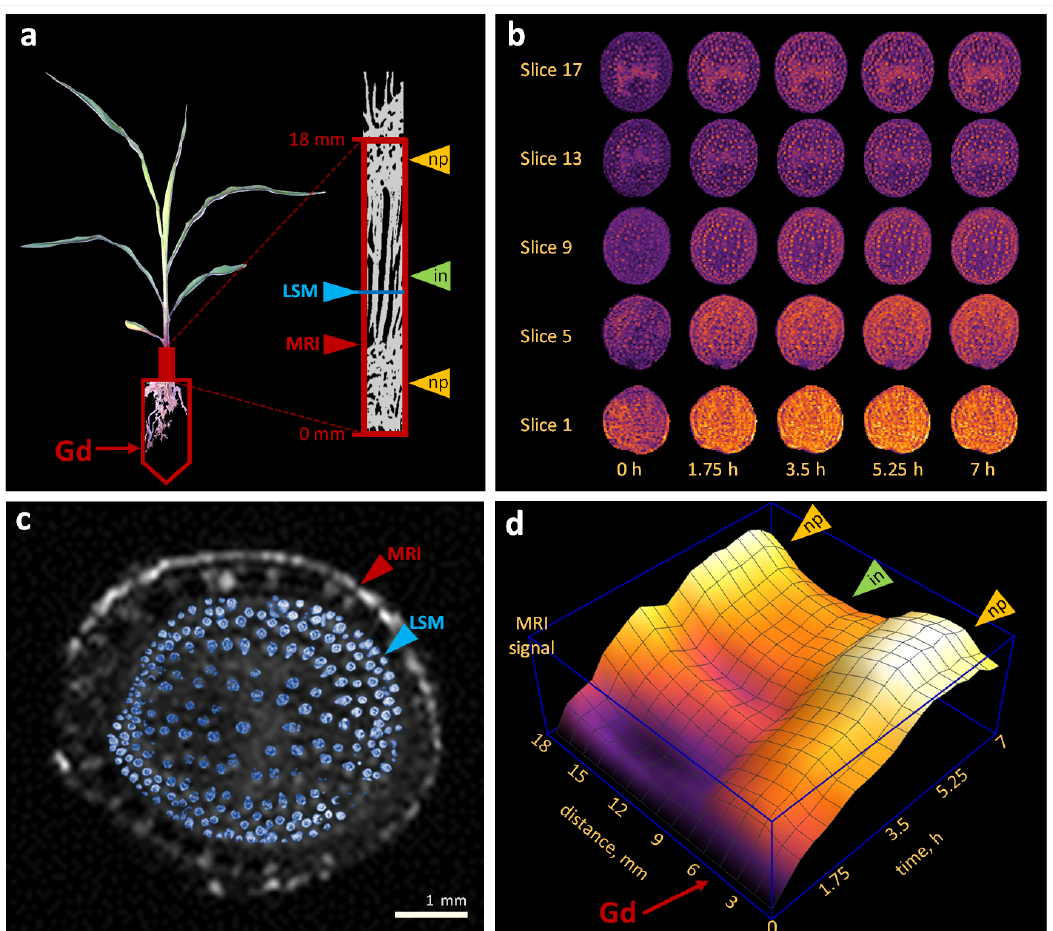
Figure 2. Contrast-enhanced MRI study of gadolinium chelate distributing inside nodal plexuses (nps) and internodes (ins) of the maize stem. ( a ) The MRI-studied area marked by the red frame was at the bottom of the maize stem, from the root/shoot nodal plexus (np) to a height of 18 mm. The location of the internode (in) section for high-resolution LSM-imaging is marked with a blue arrow. ( b ) Temporal series of MRI slices. ( c ) Matching of internodal vascular bundles in the MRI slice and in the high-resolution LSM-image. ( d ) Space–time distribution of MRI signal reflecting Gd penetration into the maize stem xylem vascular system. The red arrow indicates the roots/stem connection region, which can be interpreted as a source of gadolinium